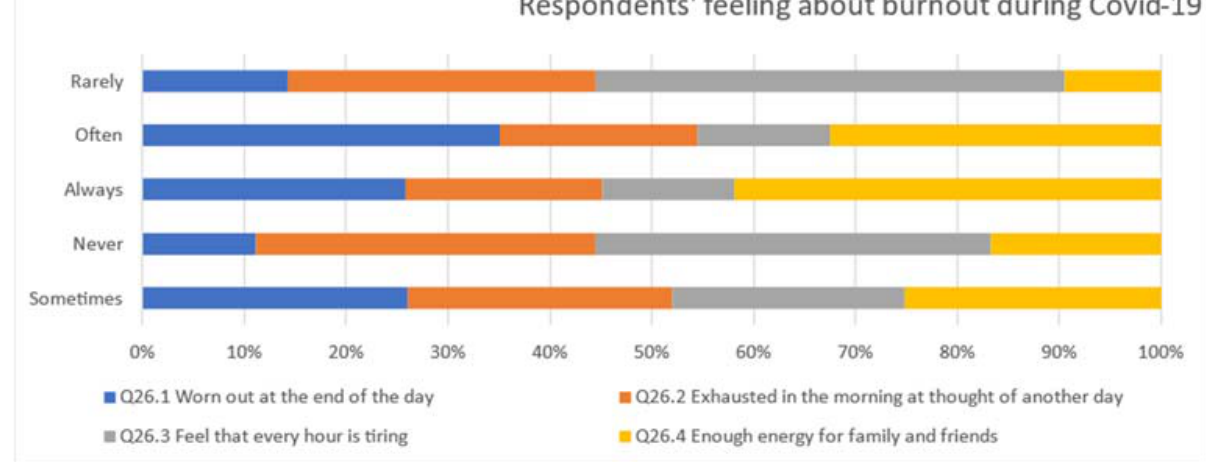
Figure 1. Feelings of burnout during COVID-19.